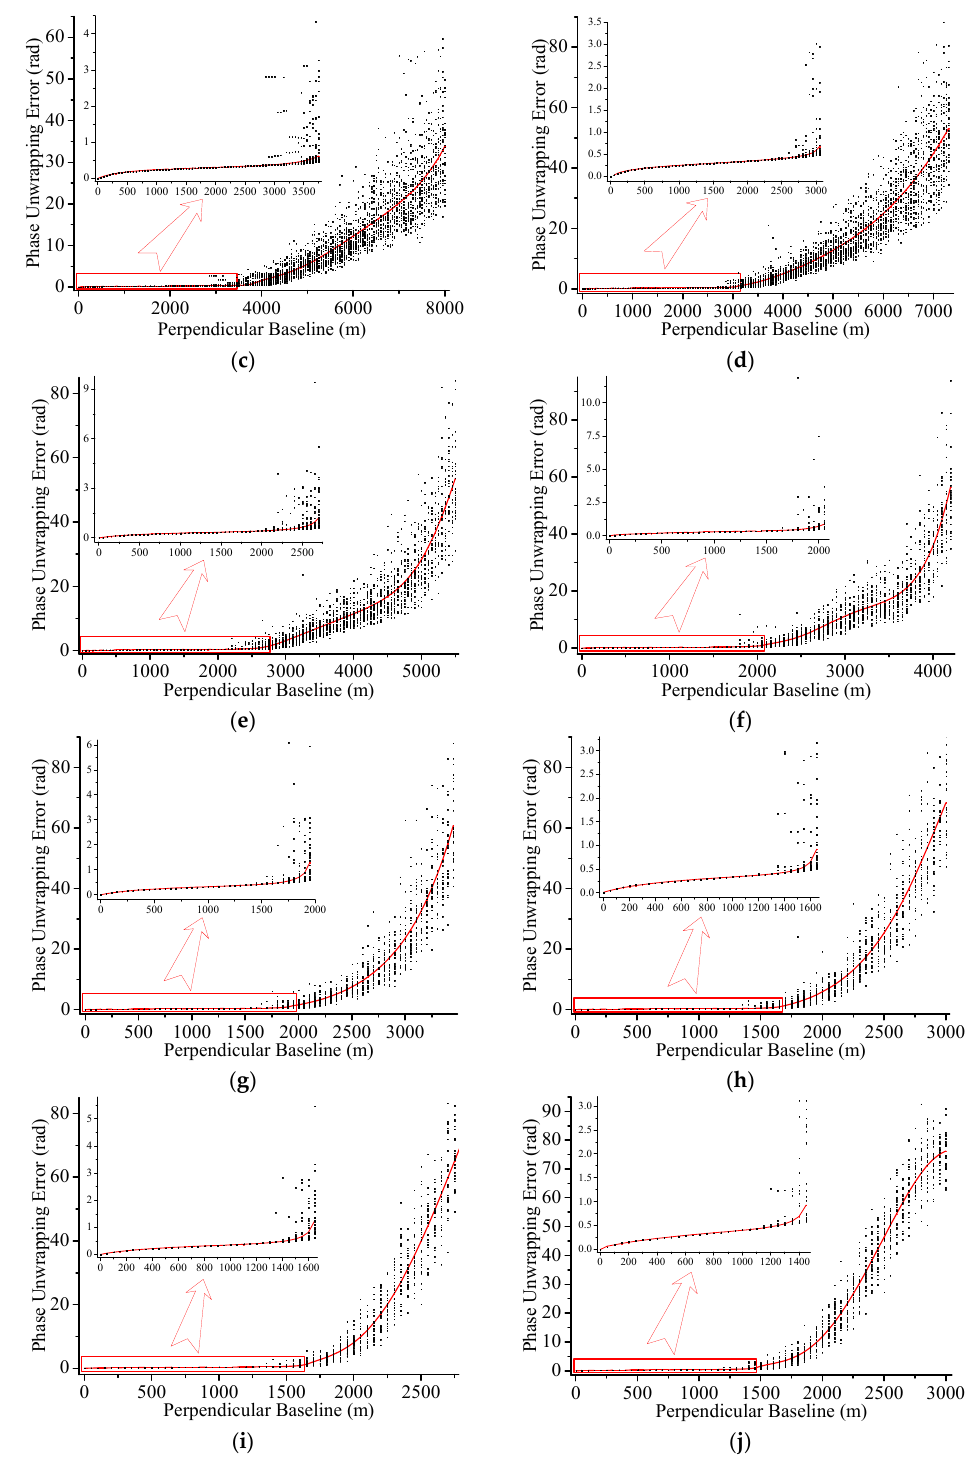
Figure 4. Fitted results with di ff erent terrain slope angles η . ( a ) Comparison of PUE models with di ff erent slope angles; ( b ) η = 0 ◦ ; ( c ) η = 2 ◦ ; ( d ) η = 4 ◦ ; ( e ) η = 6 ◦ ; ( f ) η = 8 ◦ ; ( g ) η = 10 ◦ ; ( h ) η = 12 ◦ ; ( i ) η = 14 ◦ ; and ( j ) η = 16 ◦